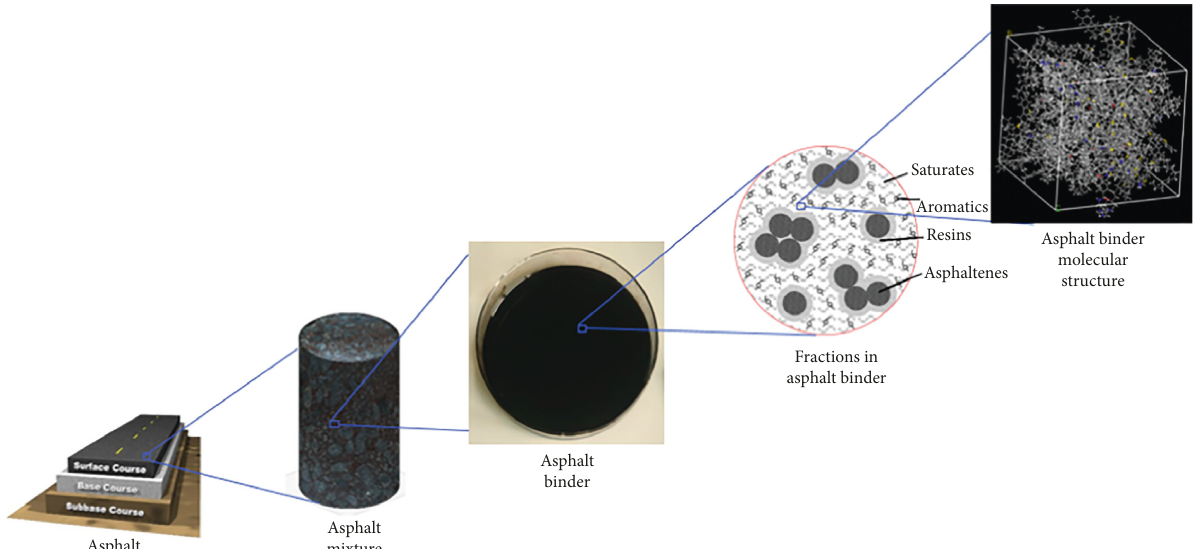
Figure 1: Asphalt research from macrolevel to microlevel.